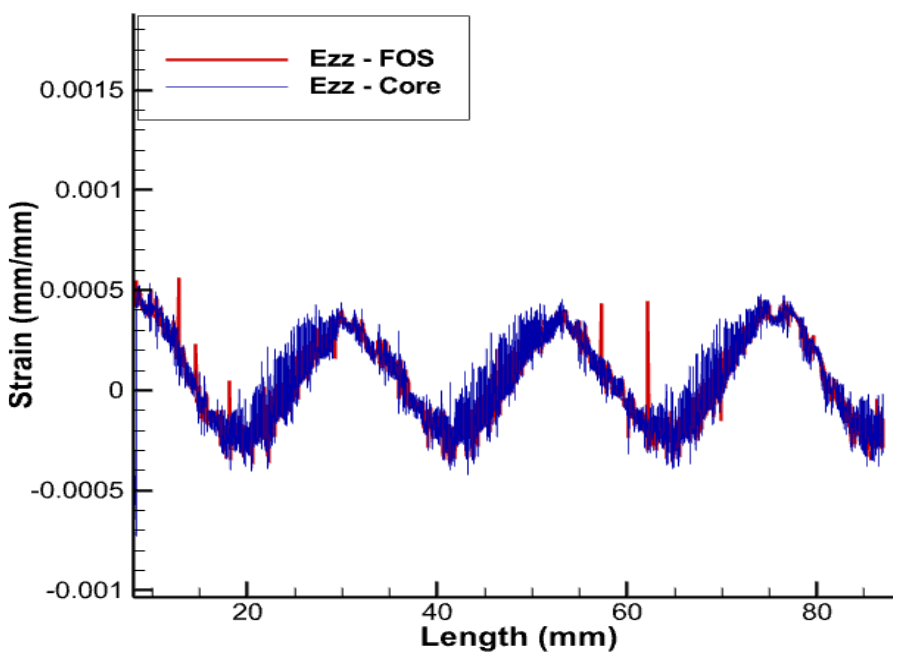
Figure 12. E zz for helical arrangement of